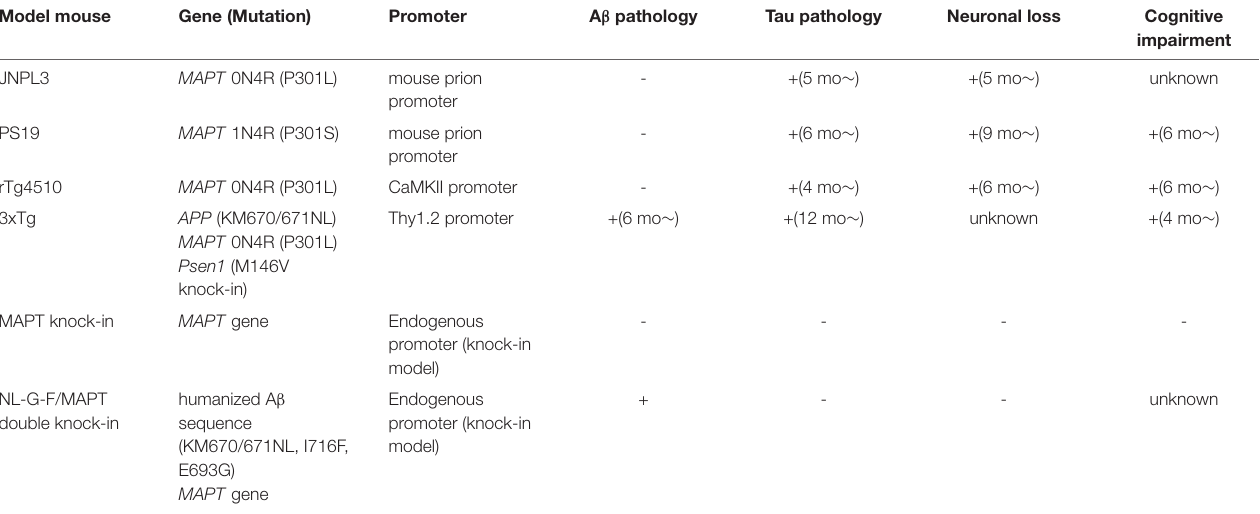
TABLE 5 | Representative tau model